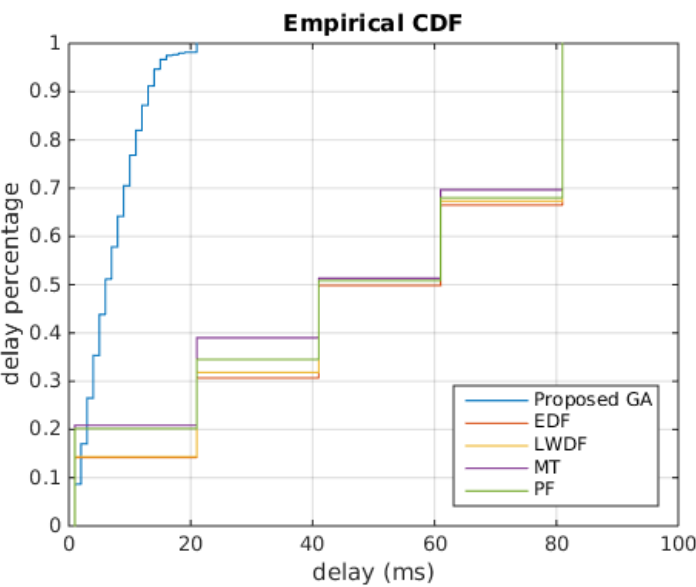
Figure 10. Cumulative Distribution function of delay. Proposed GA showed better performances than other